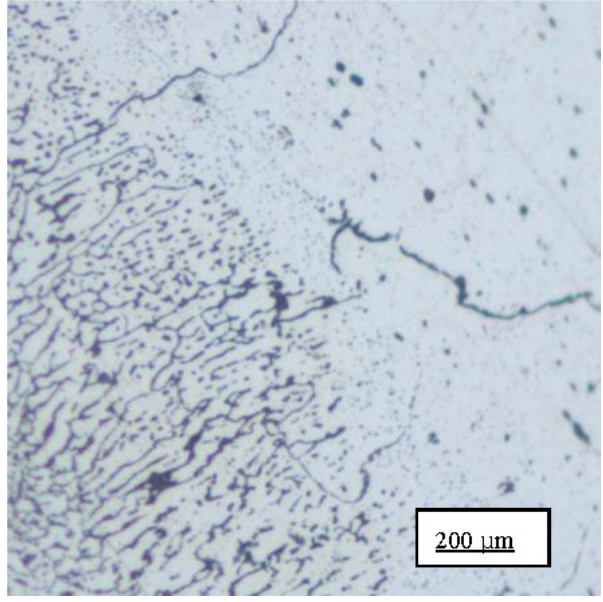
Figure 12. Optical micrograph showing region experiencing secondary melting in the weld-base metal fusion line in aluminum alloy 6061.